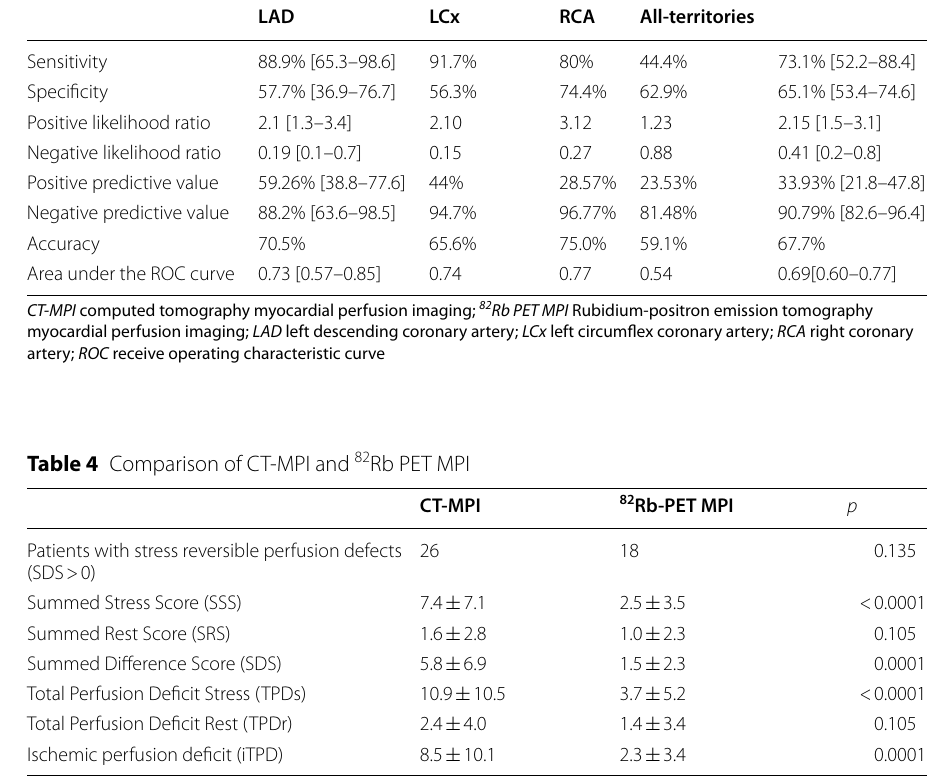
standard deviation ±